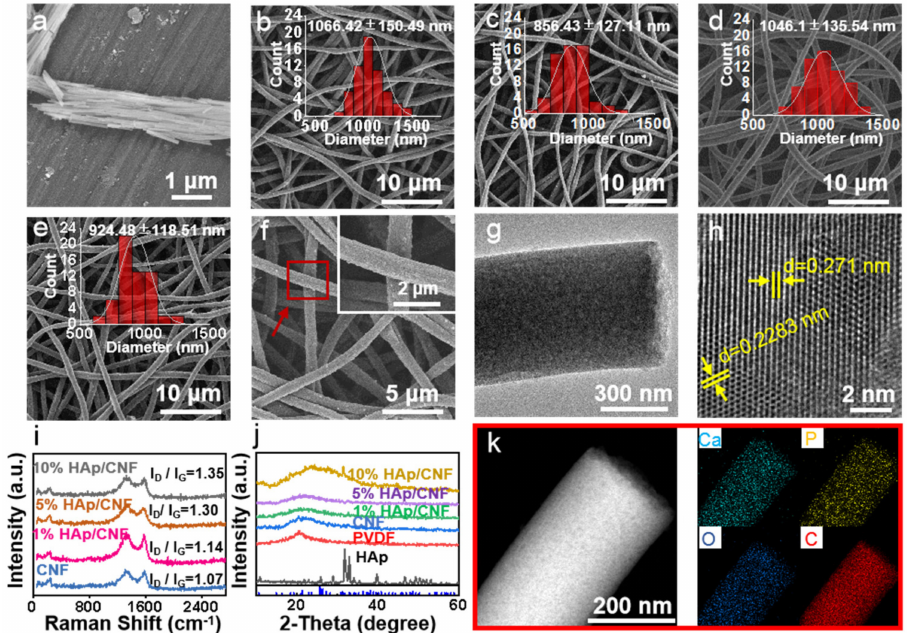
Figure 1. ( a ) SEM image of HAp. ( b ) SEM image of CNF. ( c ) SEM image of 1% HAp/CNF. ( d ) SEM image of 5% HAp/CNF. ( e ) SEM image of 10% HAp/CNF with the statistical distribution of fiber diameter fitted using Gaussian curve in the insets. ( f ) SEM images of 10% HAp/CNF at different magnifications. ( g , h ) TEM images of 5% HAp/CNF at different magnifications. ( i ) Raman spectrum of CNF and HAp/CNF with different concentrations of HAp. ( j ) XRD patterns of CNF and HAp/CNF with different concentrations of HAp. ( k ) EDS mapping images of